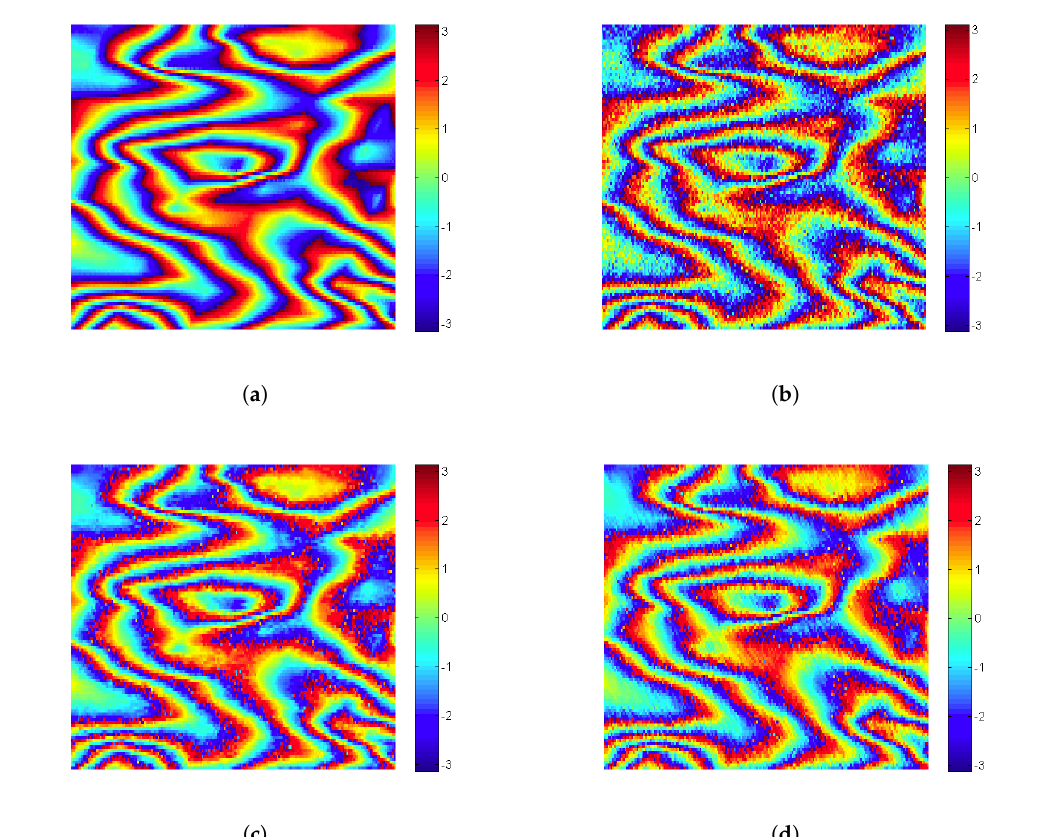
100 patch of simulated interferogram from ERS data of Rome (Italy): Figure 6. Extracted 100 × ( a ) simulated noise-free interferogram ( X ); ( b ) simulated data corrupted by an additive white noise with standard deviation equal to 0.5 ( Y = X + ν ); ( c ) denoised interferogram obtained by K-SVD ( ˆ X ); ( d ) denoised interferogram obtained by ProK-SVD ( ˆ X prox ). ( 0 ) For producing Figure 6, the initial dictionaries D were chosen as the columns of the X k k